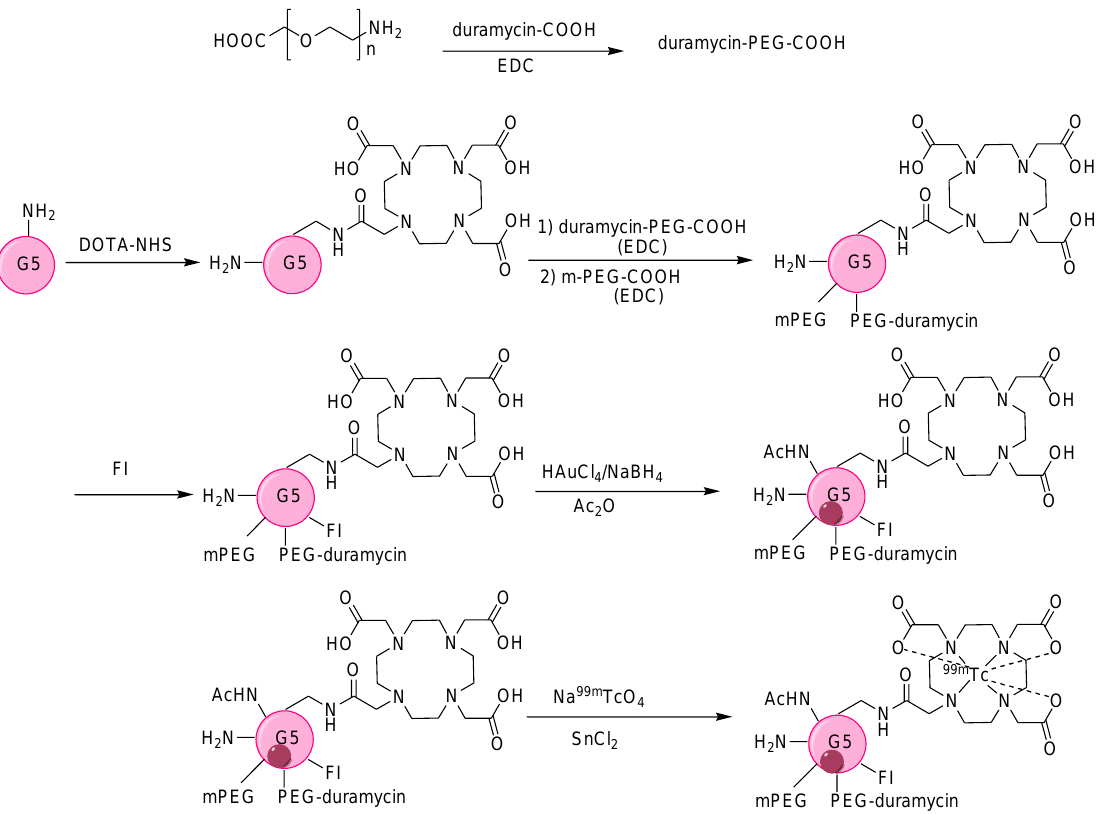
Figure 6. Synthesis of multifunctional {(Au 0 ) 200 -G5.NHAc- 99m Tc-DOTA-FI-mPEG-(PEG-duramycin)} DENPs [44].